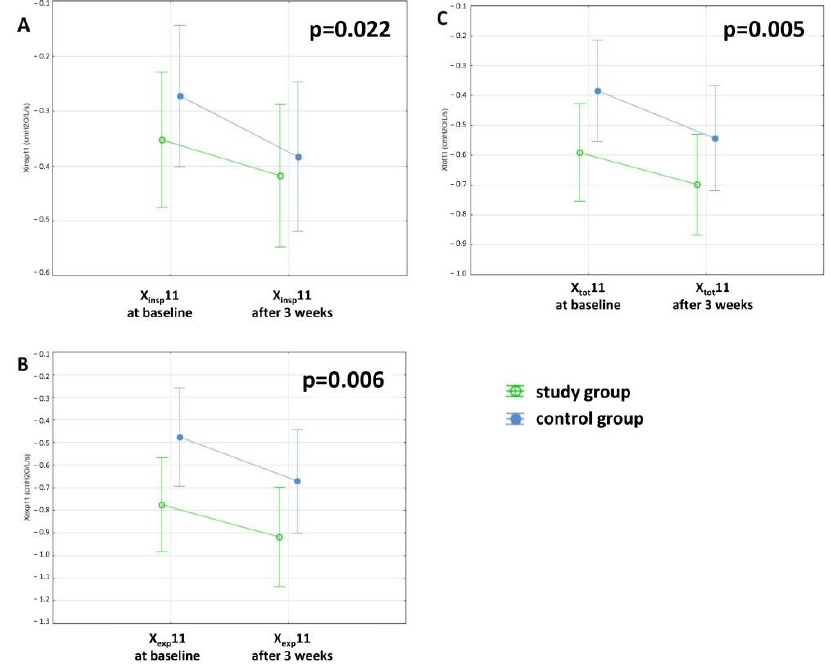
Figure 6. 3-week deterioration in reactance at 11 Hz (X11) in the study and control groups, ( A ) in- spiratory (insp), ( B ) expiratory (exp) and ( C ) total (tot), respectively. Table 8. Correlations between Factors and changes in FVC (∆FVC) and 6MWD (∆6MWD) in the study group. ∆ FVC